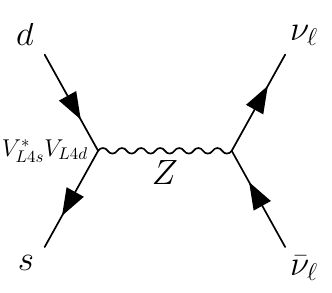
Figure 6 . Tree level contribution to the rare kaon decays K + → π + ν ¯ ν , K 0 → π 0 ν ¯ ν arising from the mixing of the SM families with the extra downtype vectorlike